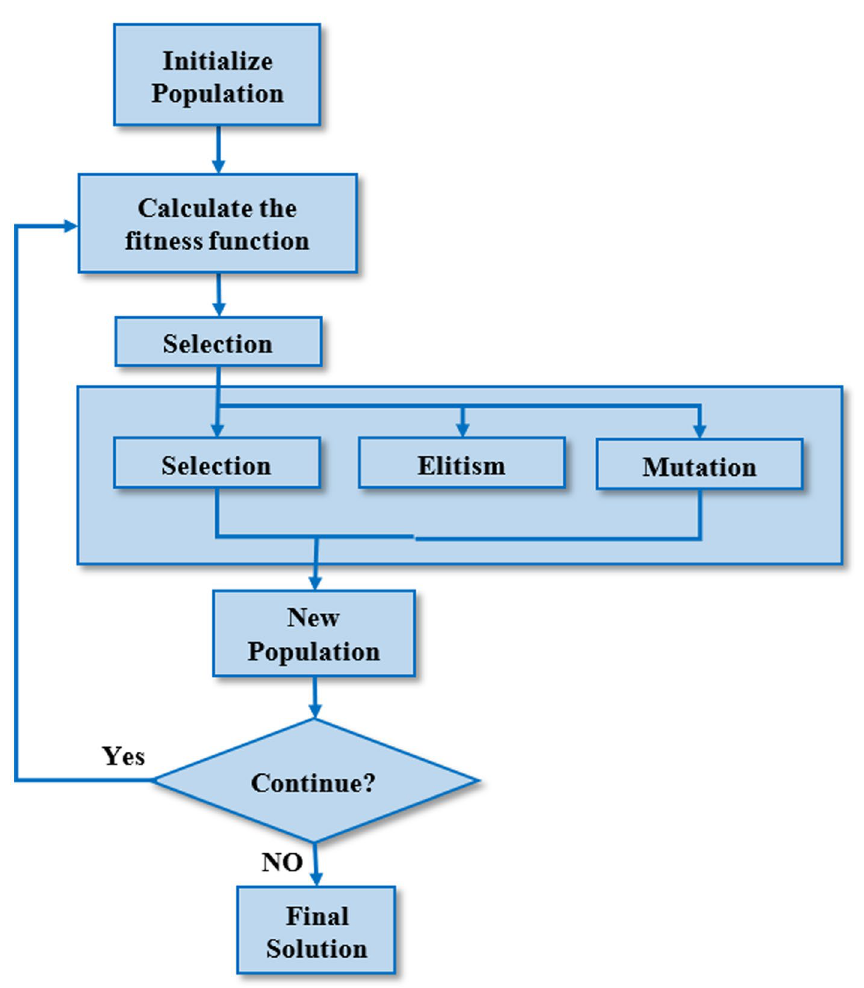
Fig. 1 Flow diagram for the sequence involved in a generic genetic algorithm for optimiza- tion